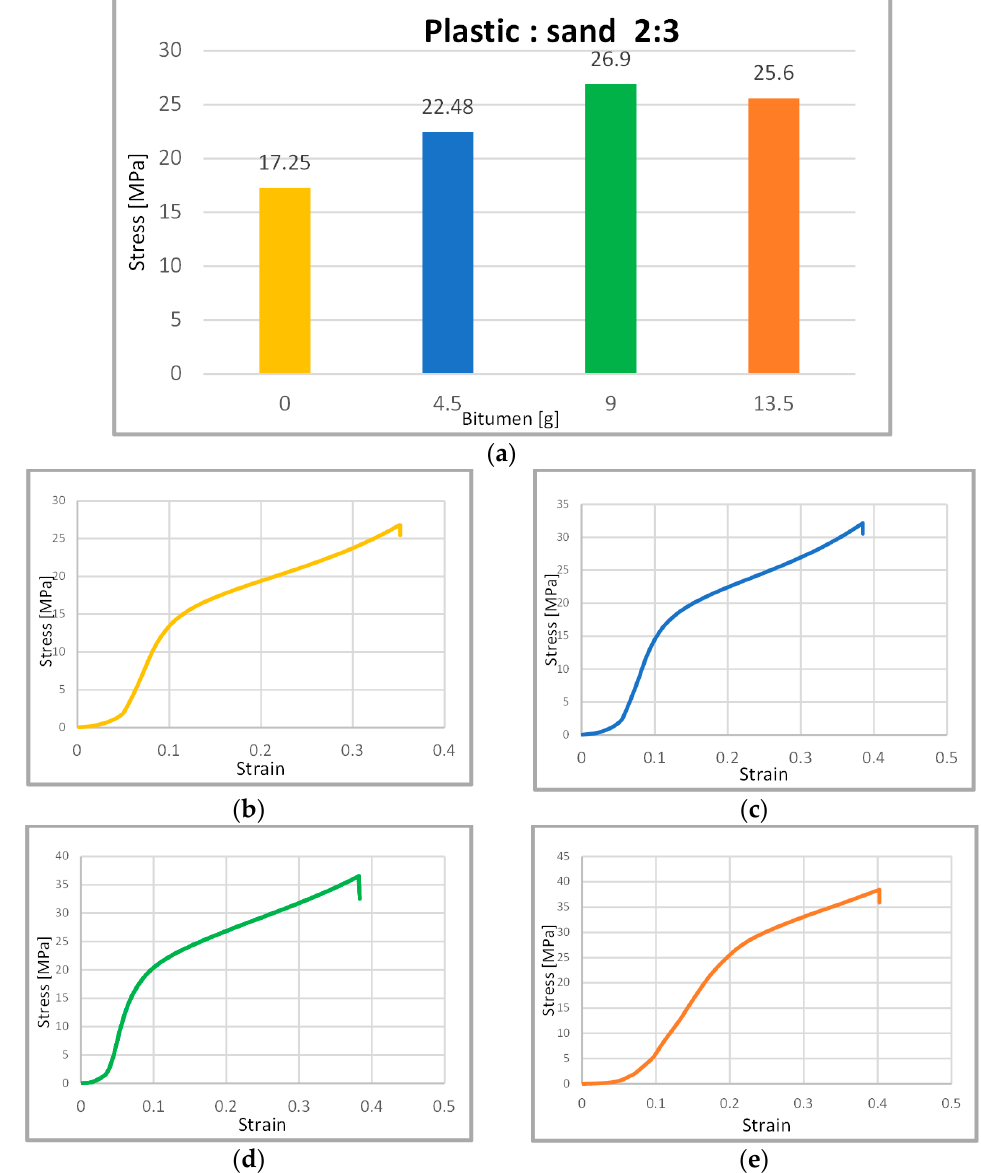
Figure 5. Results of brick sample 4. ( a ) Compression strength values of brick plastic-to-sand 2:3. ( b ) Stress–strain curve with 0 g bitumen. ( c ) Stress–strain curve with 4.5 g bitumen. ( d ) Stress–strain curve with 9 g bitumen. ( e ) Stress–strain curve with 13.5 g bitumen.